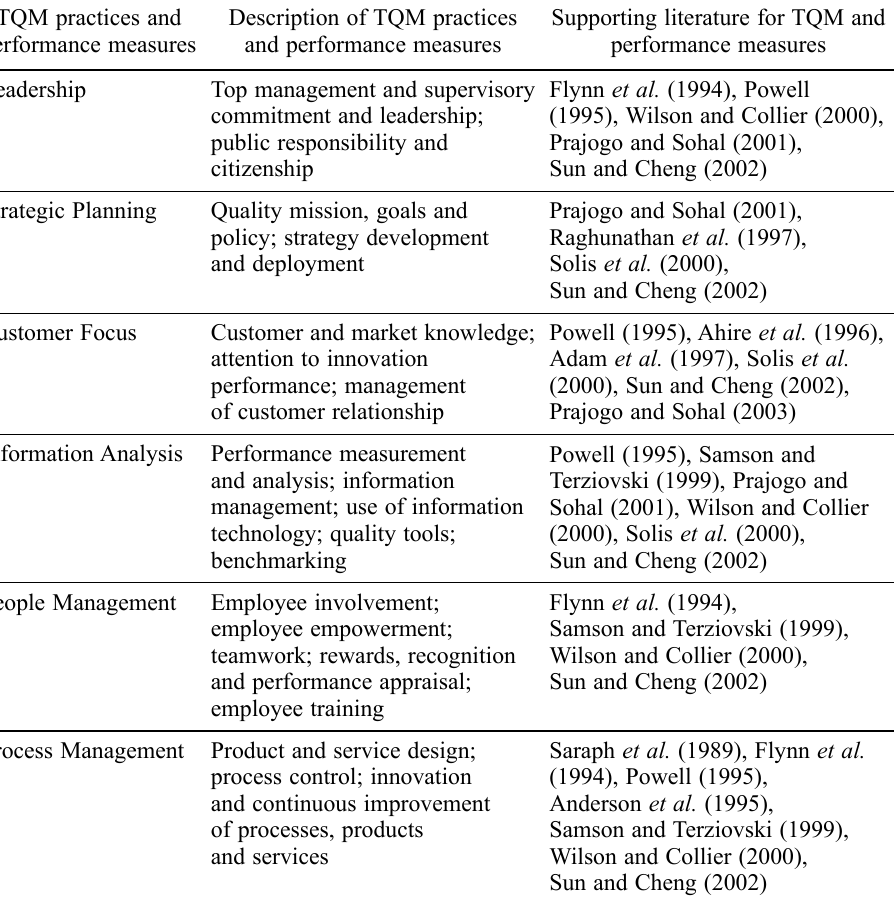
Table 1. List of studies and dimensions of